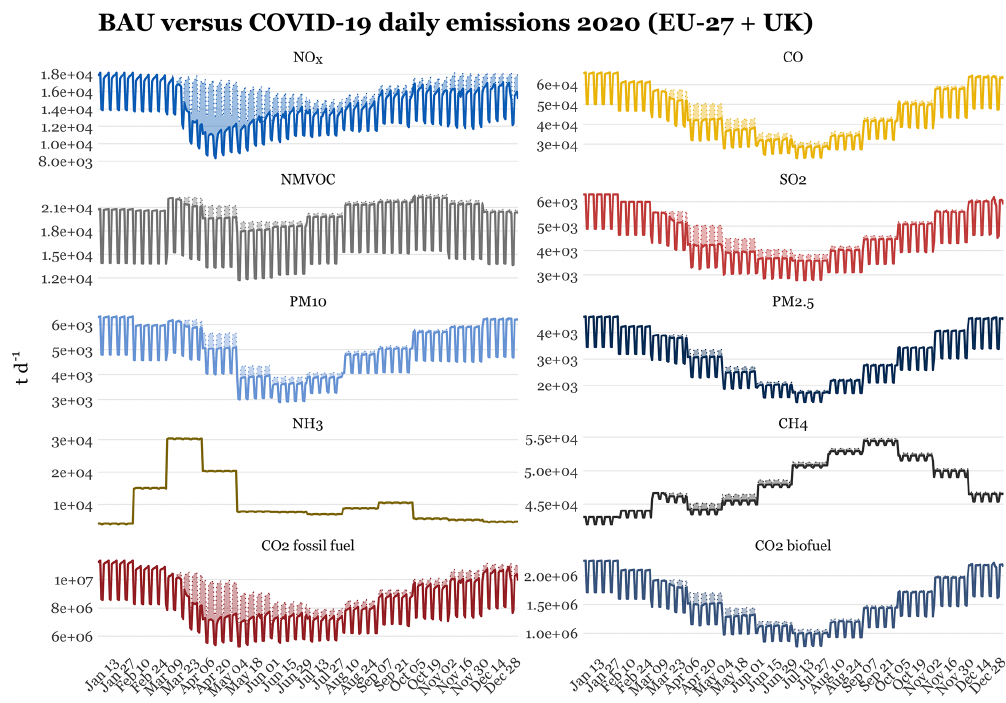
Figure 5. Daily emissions [td − 1 ] by pollutant computed for the 2020 business-as-usual (BAU) (dotted lines) and COVID-19 (solid lines) scenarios between 1 January and 31 December 2020 for EU27 + UK. The areas highlighted between the two lines represent the emission differences between